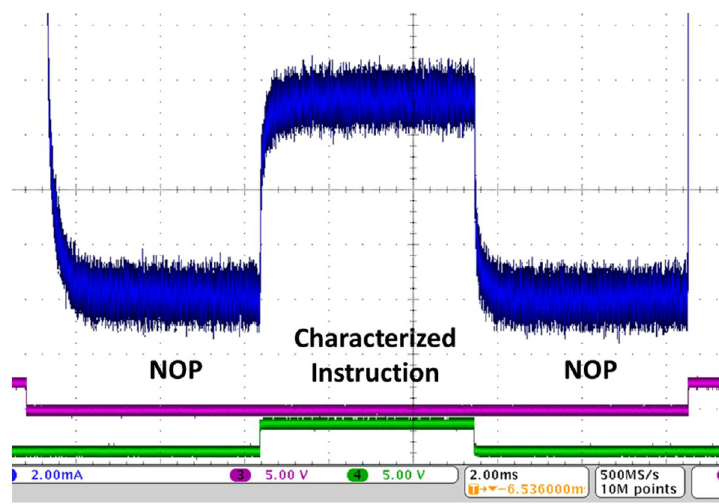
Figure 3. Example of power measurement for instruction characterization.